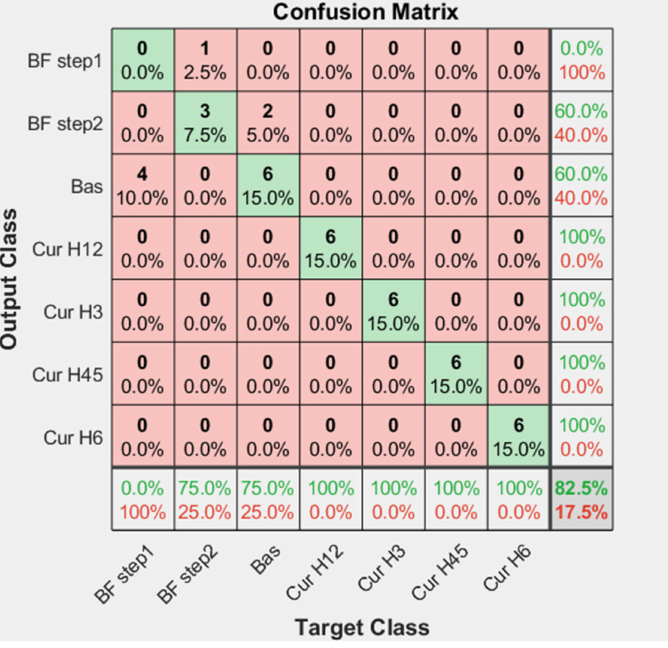
Figure 12. Confusion matrix (test set) for the seven classes of current signal